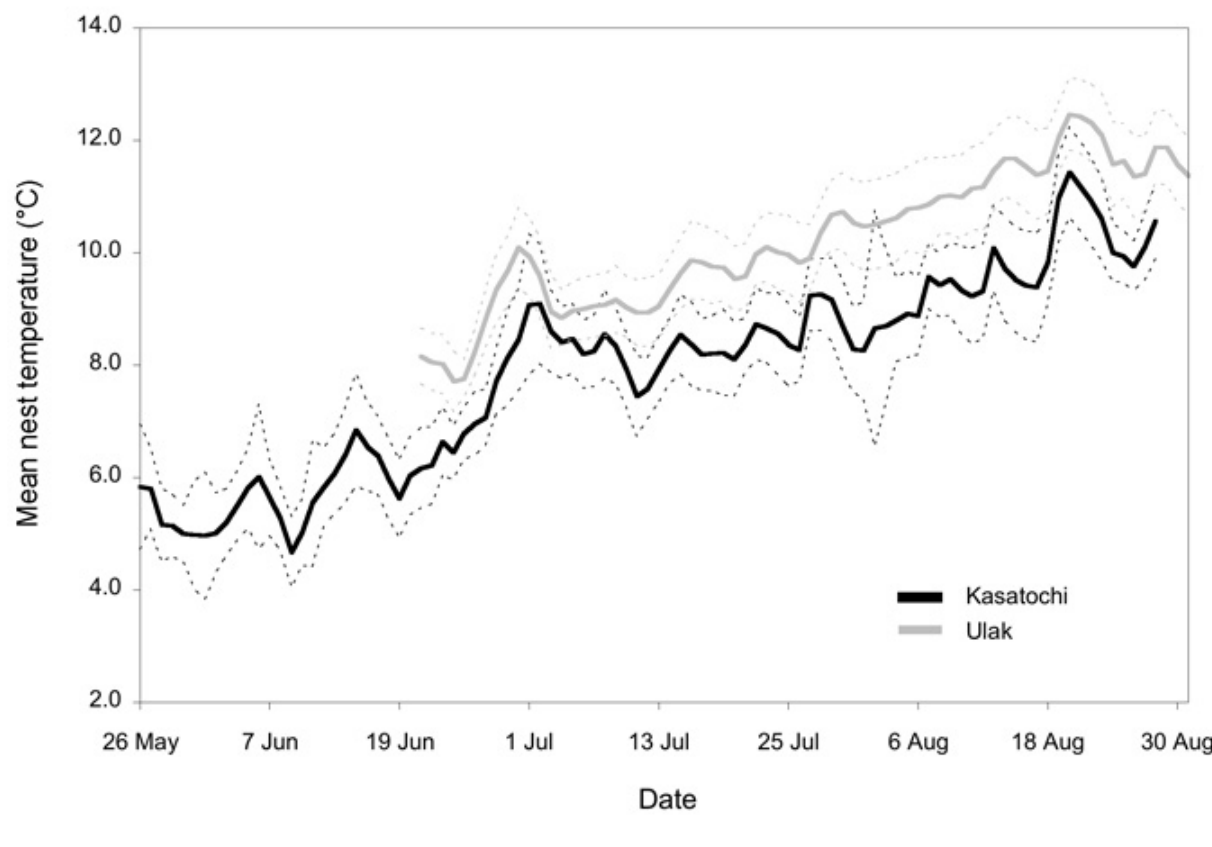
Fig. 4 . Mean daily nest temperature (°C) in Fork-tailed Storm-Petrel ( Oceanodroma furcata ) nests on Kasatochi ( n = 82) and Ulak ( n = 15) Islands, Alaska in 2006. Dashed lines represent 95% confidence